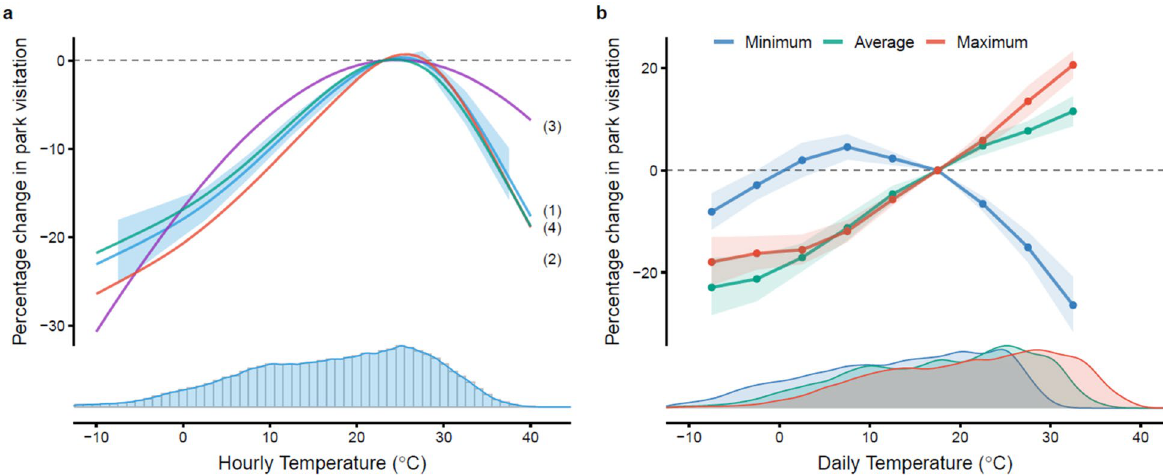
Figure 1. Temperature effects on park visitation quantity. ( a ) Effects of hourly temperature on park visitation with different model specifications. (1) Primary setting: City-month, day-of-week, hour-of-day fixed effect (FE) + binned regression with 5 °C intervals; (2) date FE in replacement of day-of-week FE; (3) quadratic polynomial; (4) binned regression with 3 °C intervals. ( b ) Effects of daily minimum, average, and maximum temperature (6 AM to 10 PM) on park visitation. Shaded areas are 95% confidence intervals. Histogram/Density plots display the distribution of temperatures for each